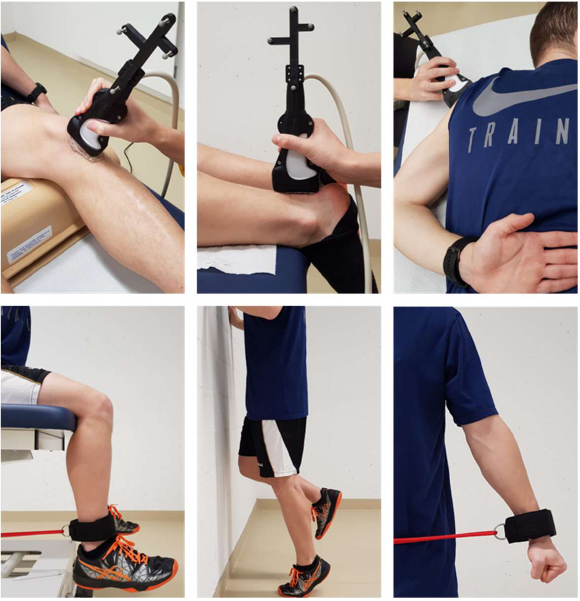
Figure 1. Top row: Subject position during ultrasound examination of the patellar, Achilles, and supraspinatus tendon, respectively. Bottom row: experimental setup used to induce tendon load- ing stimulus for either of the three tendons assessed.